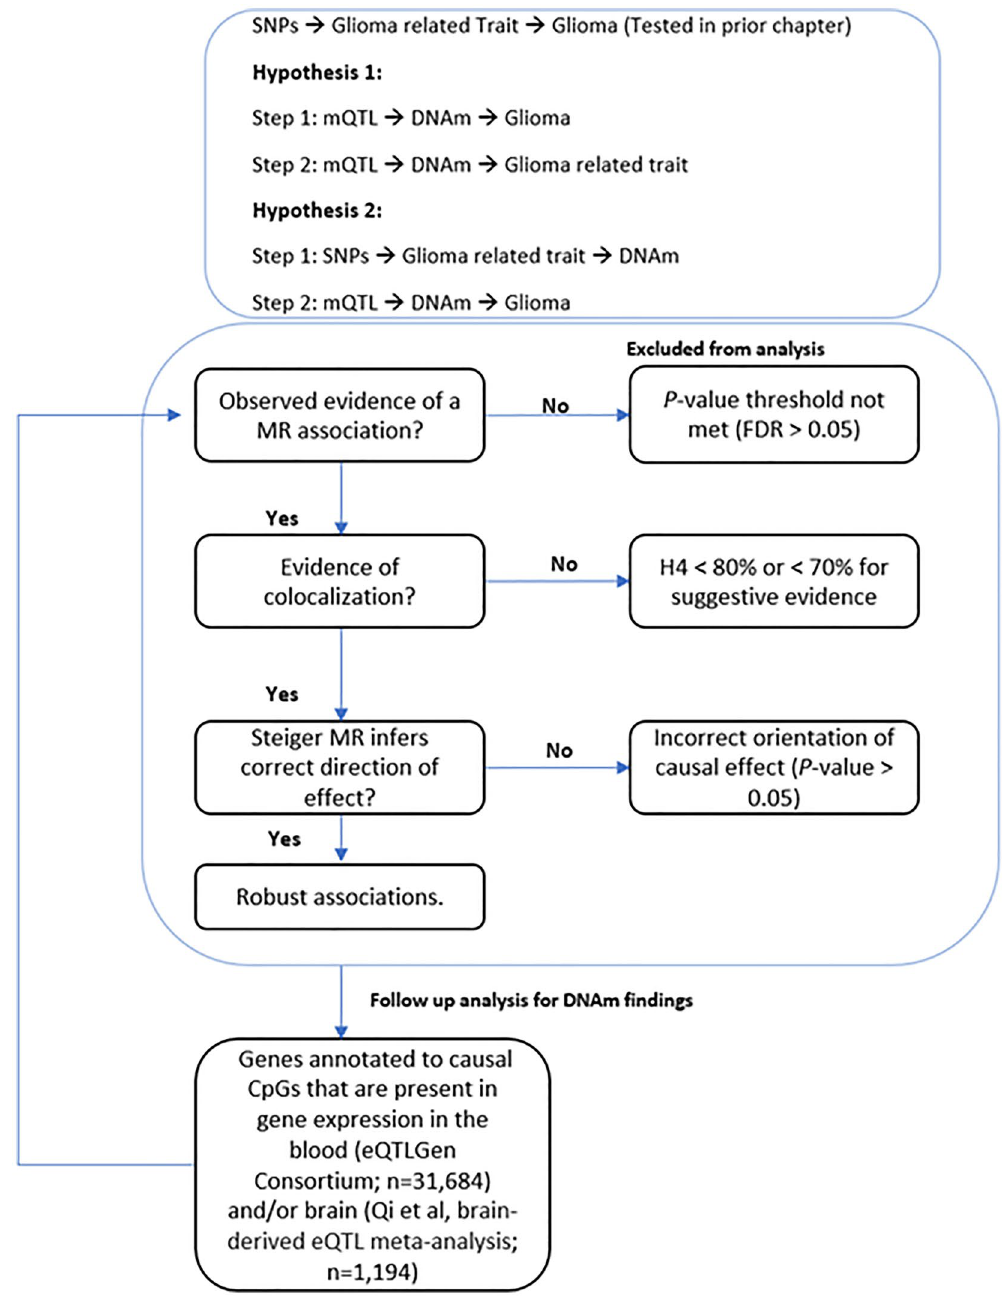
Figure 5. A summary of the MR pipeline. A summary of the analysis pipeline. All Mendelian randomization (MR) estimates were subject to further sensitivity analysis (colocalization and Steiger filtering) to enhance evidence for causal